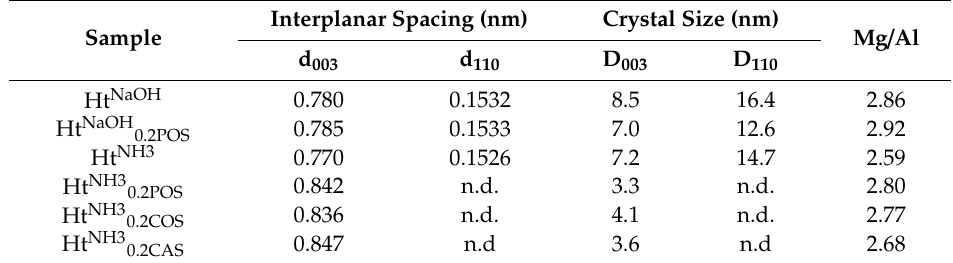
Table 1. The e ff ect of the precipitating agent and of the nature of starch on XRD determined d 003 and d 110 interplanar spacings, and D 003 and D 110 crystal sizes; EDS determined Mg / Al ratio.